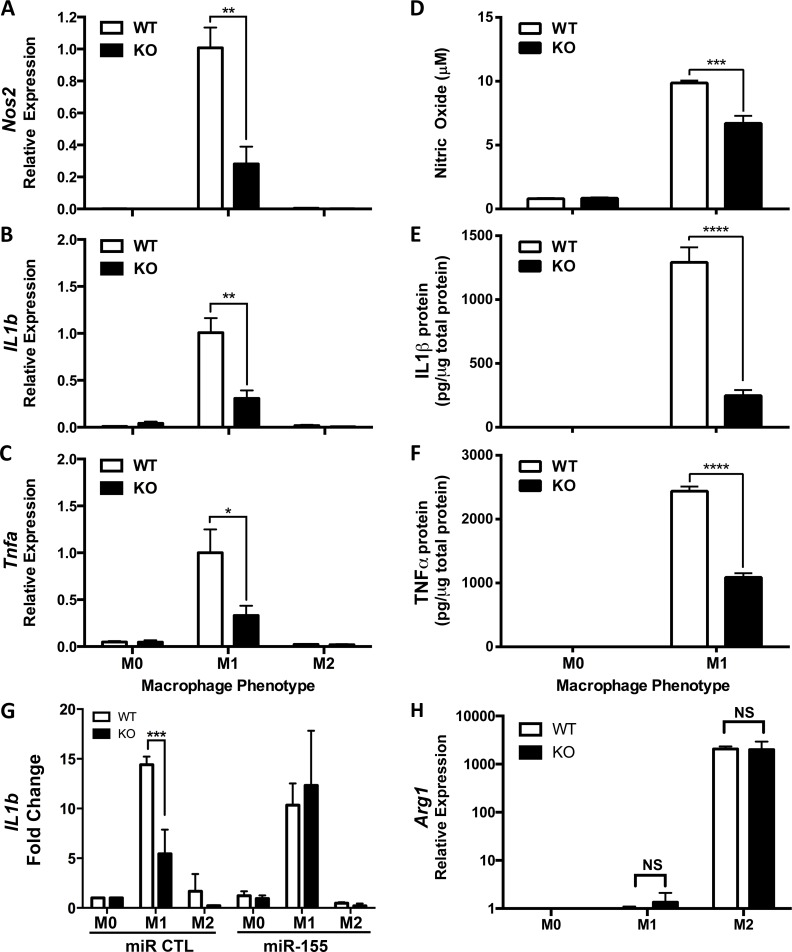
Reduced classically activated M1 marker expression in miR-155 knock-out (KO) macrophages.(A) Inducible nitric oxide synthase (Nos2), (B)
IL1b, (C) Tumor Necrosis Factor-α (Tnfa) (H) and Arginase-1 (Arg1) expression was determined by Real-Time PCR in wild-type (WT, n = 8–11) and miR-155 knockout (KO n = 8–12) bone marrow-derived macrophages in vitro activated in M1 or M2 conditions for 24 hours in three independent experiments. Gene expression is expressed as a percentage +/- SEM of the WT M1 condition. Unpaired t-test, *p<0.05, **p<0.005. Relative concentration of (D) nitric oxide (NO), (E) IL-1β protein and (F) TNF-α protein was determined using Griess assay (for NO) or Bio-Plex Suspension Array (For IL-1β and TNF-α) in cell lysates from WT (n = 5) and miR-155 KO (n = 5) bone marrow-derived macrophages in vitro activated in M1 or M2 conditions for 24 hours. Individual protein concentrations expressed as fraction of total protein concentration in either M0 or M1 condition. (G) IL1b expression was determined by Real-Time PCR in WT and KO bone marrow-derived macrophages transfected with a scrambled miR control (n = 5) or a miR-155 oligonucleotide mimic (n = 5) and activated in M0 (untreated), M1 (LPS+IFN-γ) or M2(IL-4) conditions for 24 hours. Gene expression is expressed as a percentage +/- SEM of the scrambled M1 condition. Unpaired t-test, ***p<0.0005, ****p<0.00005. (A-G) Data from 2–3 independent experiments.